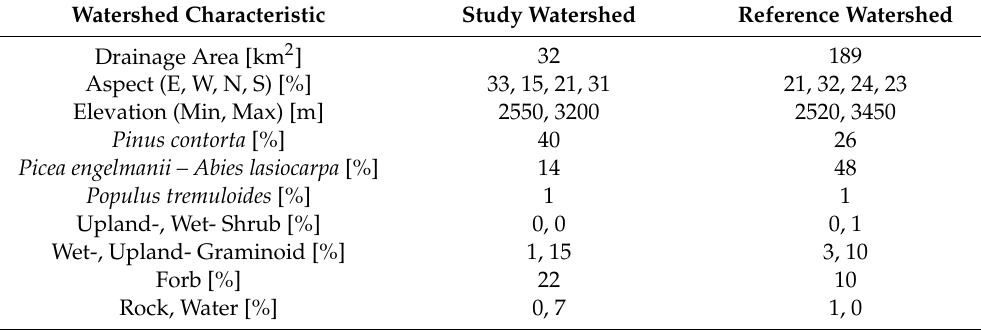
Table 1. Watershed characteristic di ff erences at the Study Watershed (Hog Park Creek above Hog Park Dam) and Reference Watershed (Encampment River above Hog Park